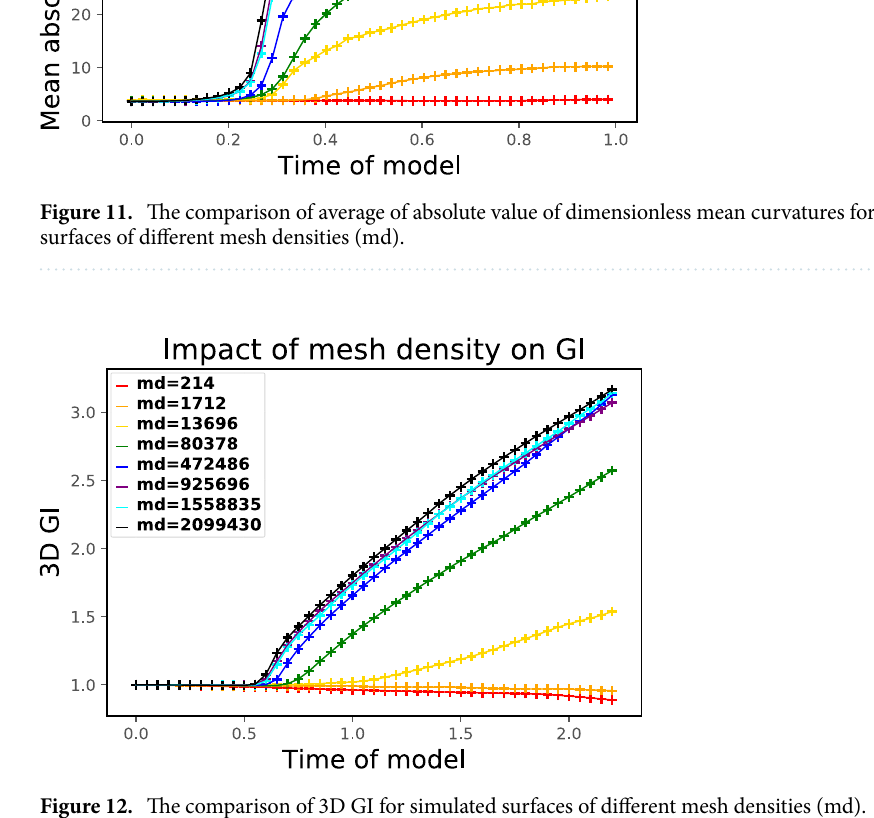
Figure 12. The comparison of 3D GI for simulated surfaces of different mesh densities